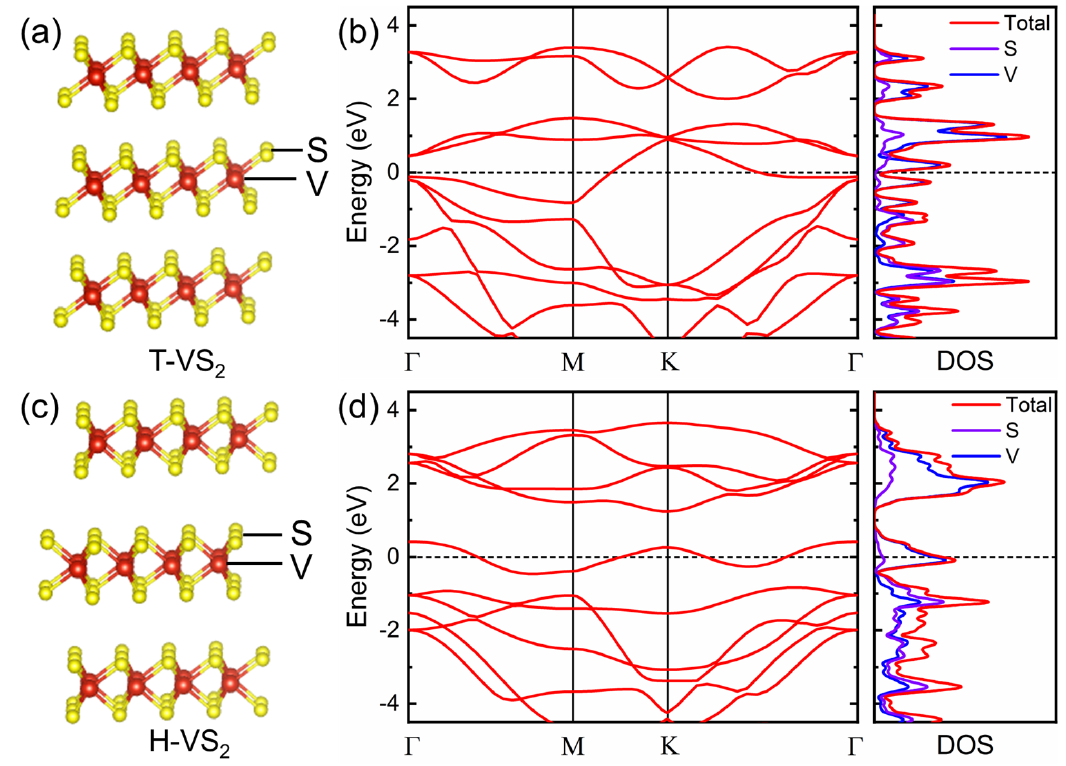
Figure 2. Lattice structure of ( a ) T-VS 2 and ( c ) H-VS 2 ; band structure diagrams and DOS of ( b ) bulk T-VS 2 and ( d ) monolayer H-VS 2 . The dotted black line indicates Fermi energy, which is assigned a value of zero.